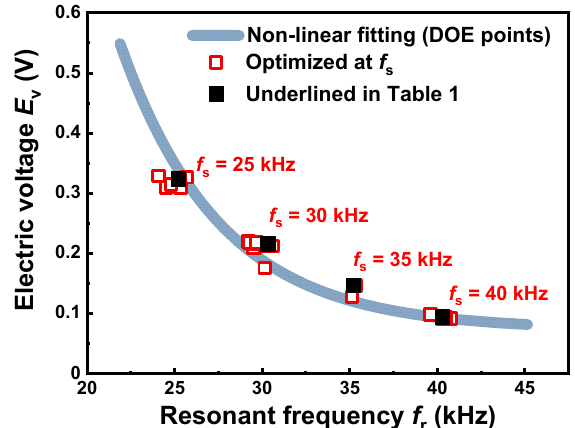
Figure 2. Optimization results of resonant frequency f r and electric voltage E v at different set values of resonant frequency f s , together with non ‐ linear fitting curve of design of experiments (DOE) test points used for numerical optimization (from ref. [10]).